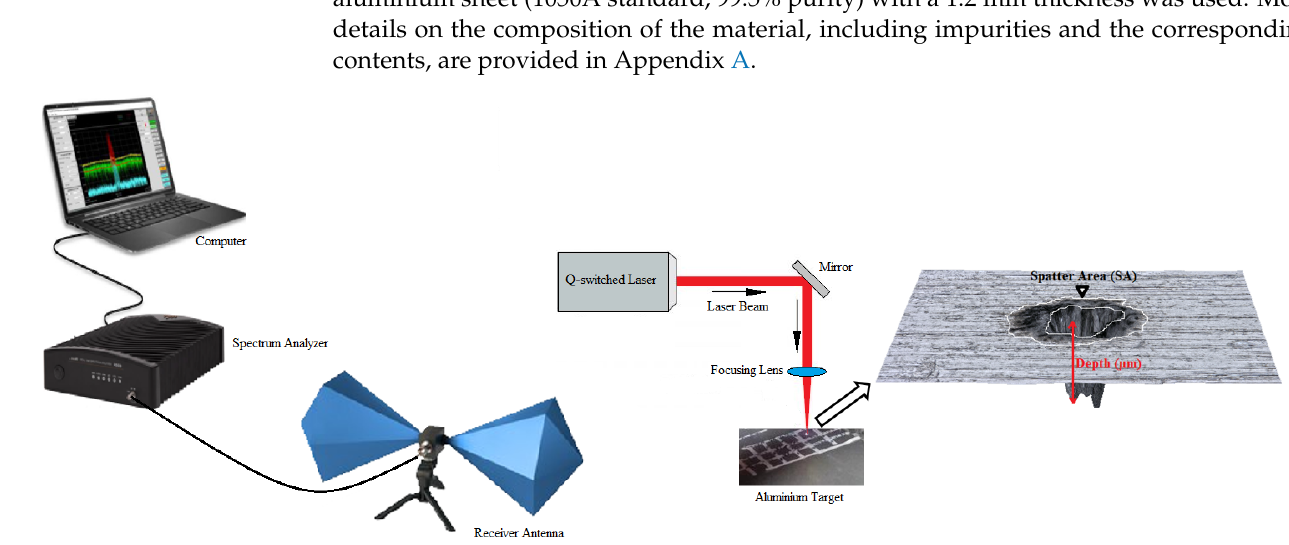
Figure 1. Schematic of the experimental setup.